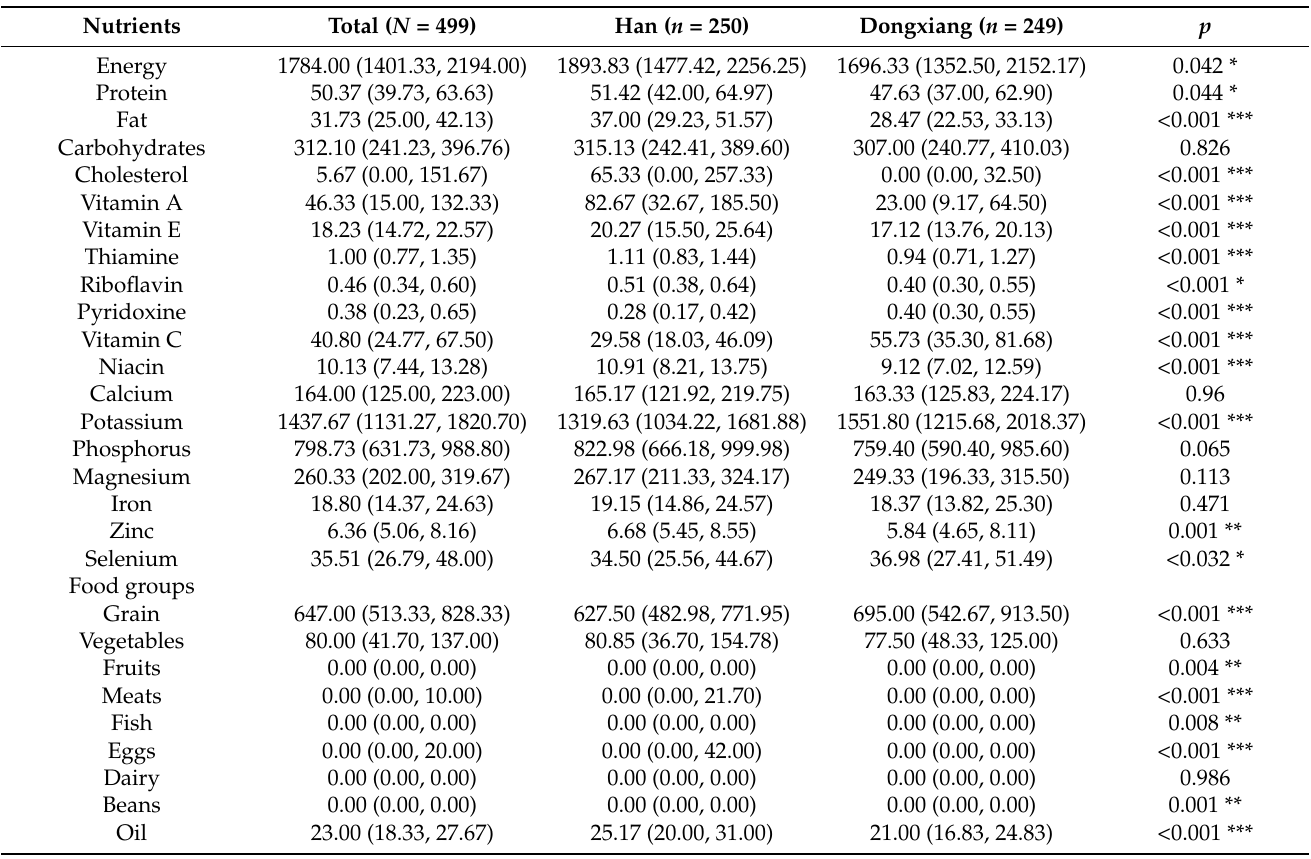
Table 2. The daily consumption of energy, nutrients, and food groups among participants by ethnicity groups ( N =